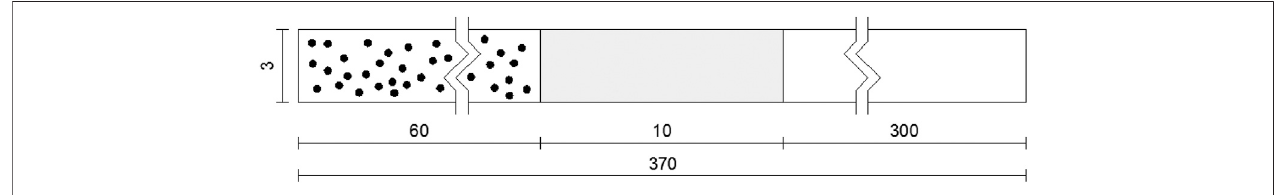
FIGURE 2 | Geometry of the footbridge (gray) and of the access route and way out (white). Black dots: example of random initial positions of pedestrians. Dimensions are in